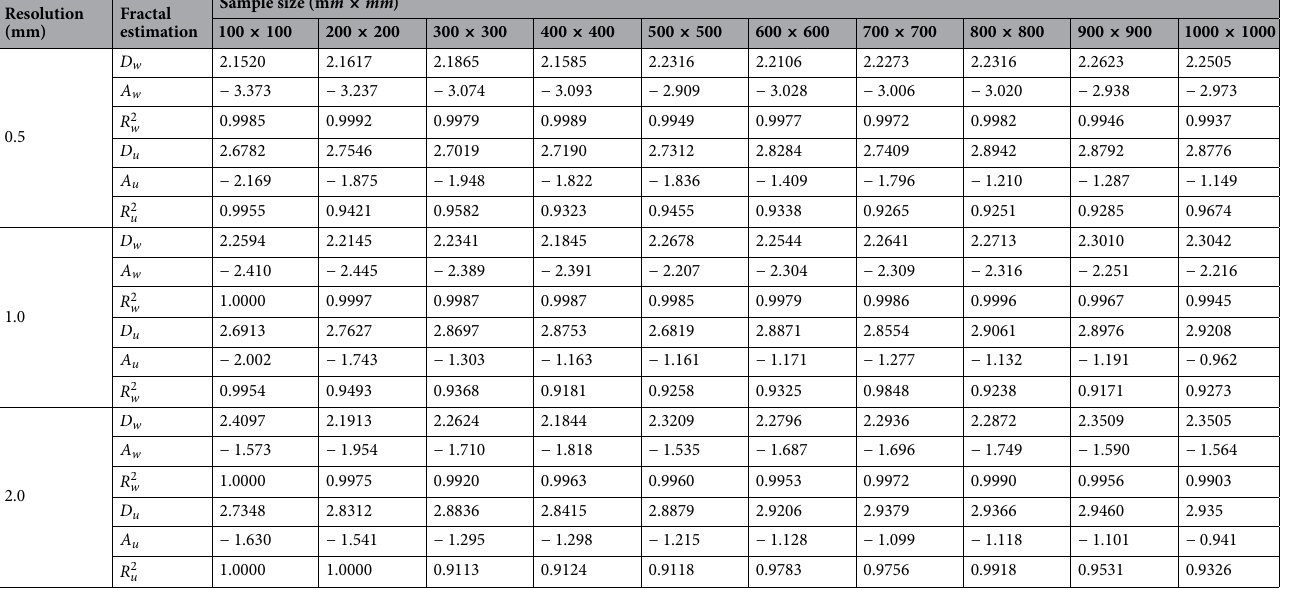
Table 1. Fractal dimensions of waviness and unevenness of rock joint sample S1 at varying sample sizes. D w and D u are fractal dimensions of waviness and unevenness, respectively. A w and A u are the coefficients during linear correlations for estimating D w and D u , respectively. R during linear correlations for estimating D w and D u , respectively.